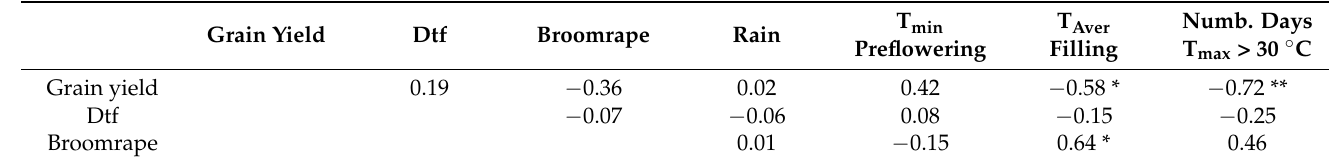
Table 7. Pearson correlations among accessed traits.